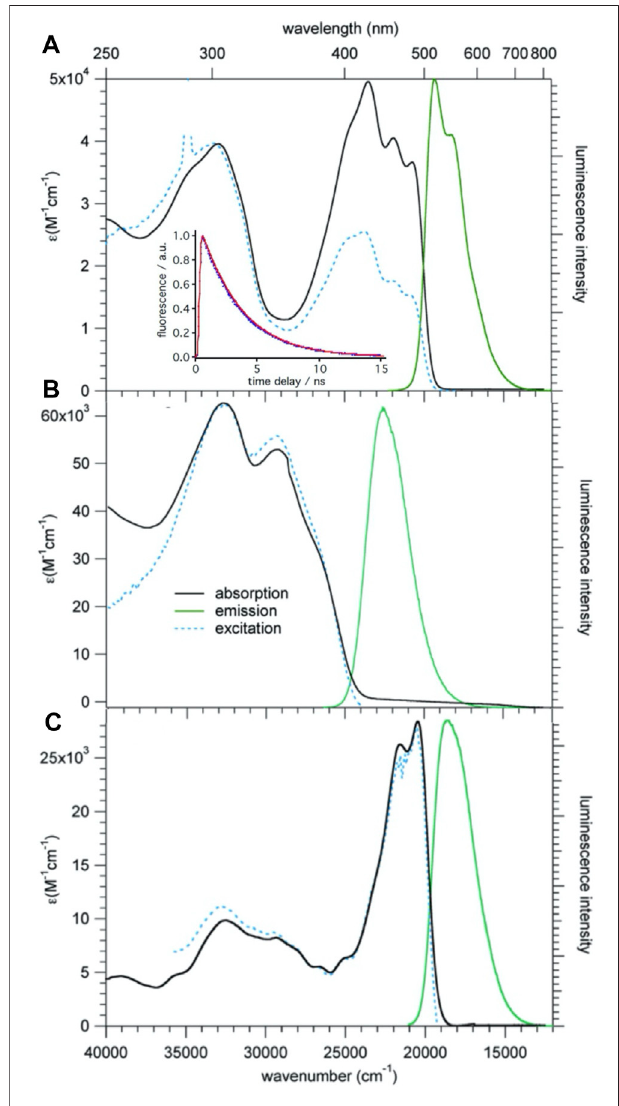
FIGURE 4 | Absorption, emission, and excitation spectra of 1 (A) , 2 (B) , and 3b (C) , c (cid:1) 10 − 5 M in CH 2 Cl 2 solution at room temperature; for the emissionand excitation spectra of 1 and 3b, λ ex (cid:1) 430 nm and λ em (cid:1) 550 nm, respectively, for 2 the corresponding values are 320 and 450 nm, respectively. Inset: luminescence decay of 1 , experimental: blue, single exponential fi t: red.